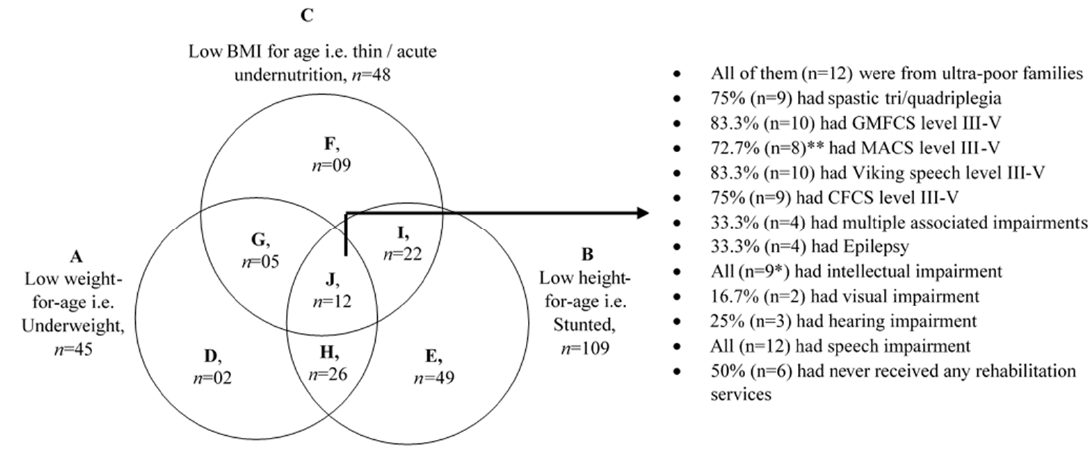
Figure 1. Overlapping of different forms of undernutrition among children with CP in NCPR. Here, (A) = Total number of